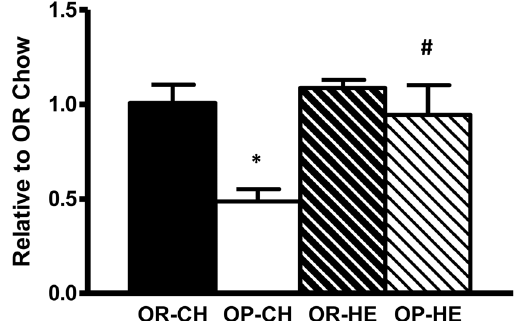
Figure 5. One-hour sham feeding intake of sucrose solutions for chow- and HE-fed OP and OR rats. Chow-fed OP rats had decreased intakes of 0.3 M and 1.0 M sucrose solutions compared to OR rats. HE-feeding resulted in decreased intakes of 0.3 M and 1.0 M sucrose solutions in OR rats. *P , 0.05 OP relative to OR within diet condition; { P , 0.05 HE-OR relative to chow-OR.